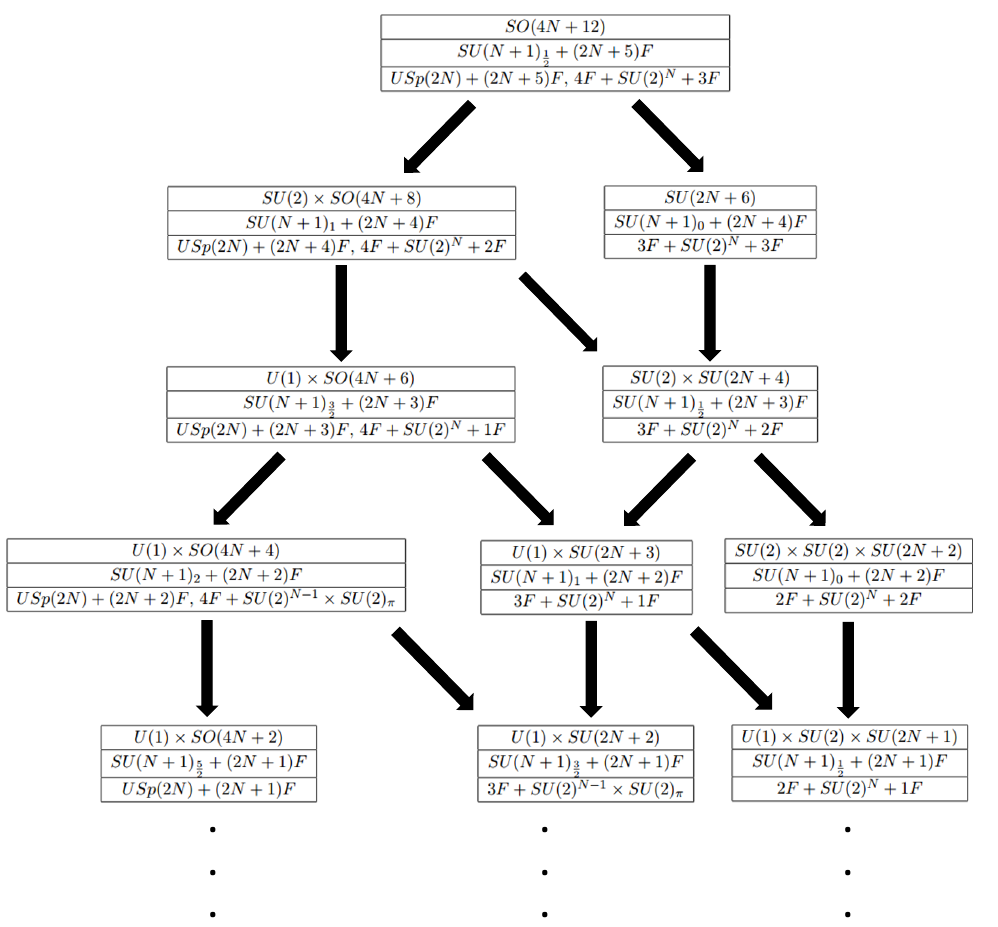
Figure 3 . An illustration of the flow chart for 5 d SCFTs. Here each table represents a 5 d SCFT with the top entry denoting its global symmetry, the middle one giving its SU type gauge theory description and the bottom one detailing additional gauge theory descriptions. Arrows between the different tables indicate mass deformations between the different 5 d SCFTs. Here only the top cases are shown, and the flows continue to other 5 d SCFTs that UV complete SU( N + 1) k + N f F gauge theories with N f < 2 N + 1